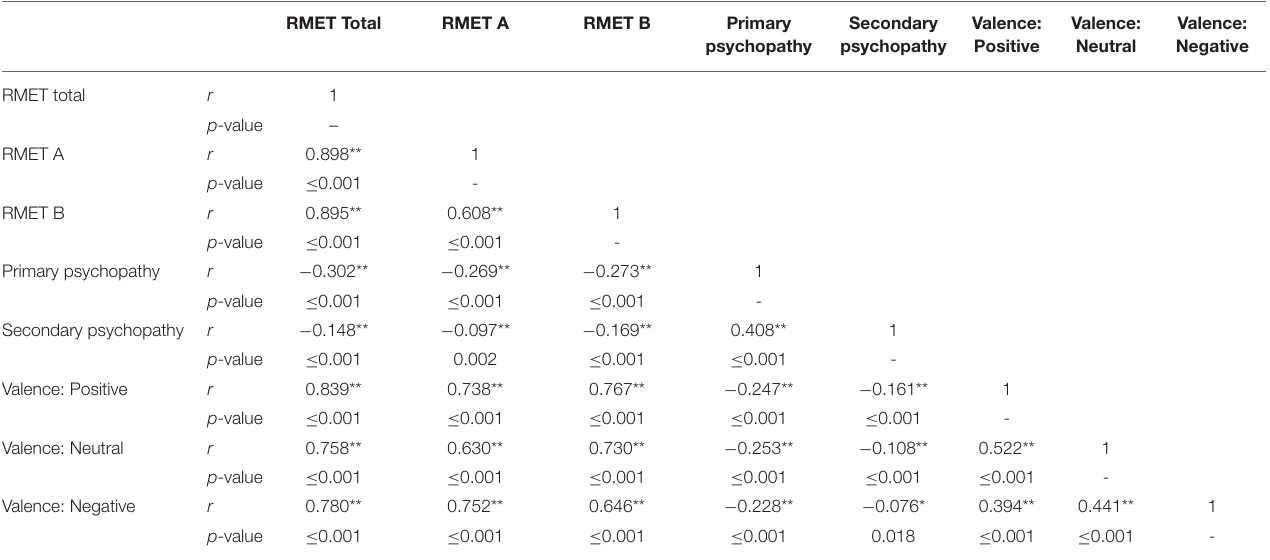
TABLE 2 | Correlation coefficients for the total group ( N = 1,000).